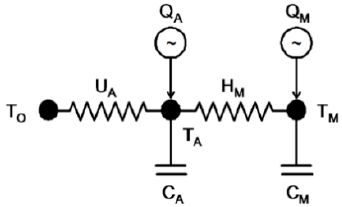
Figure 2. Equivalent thermal parameters circuit